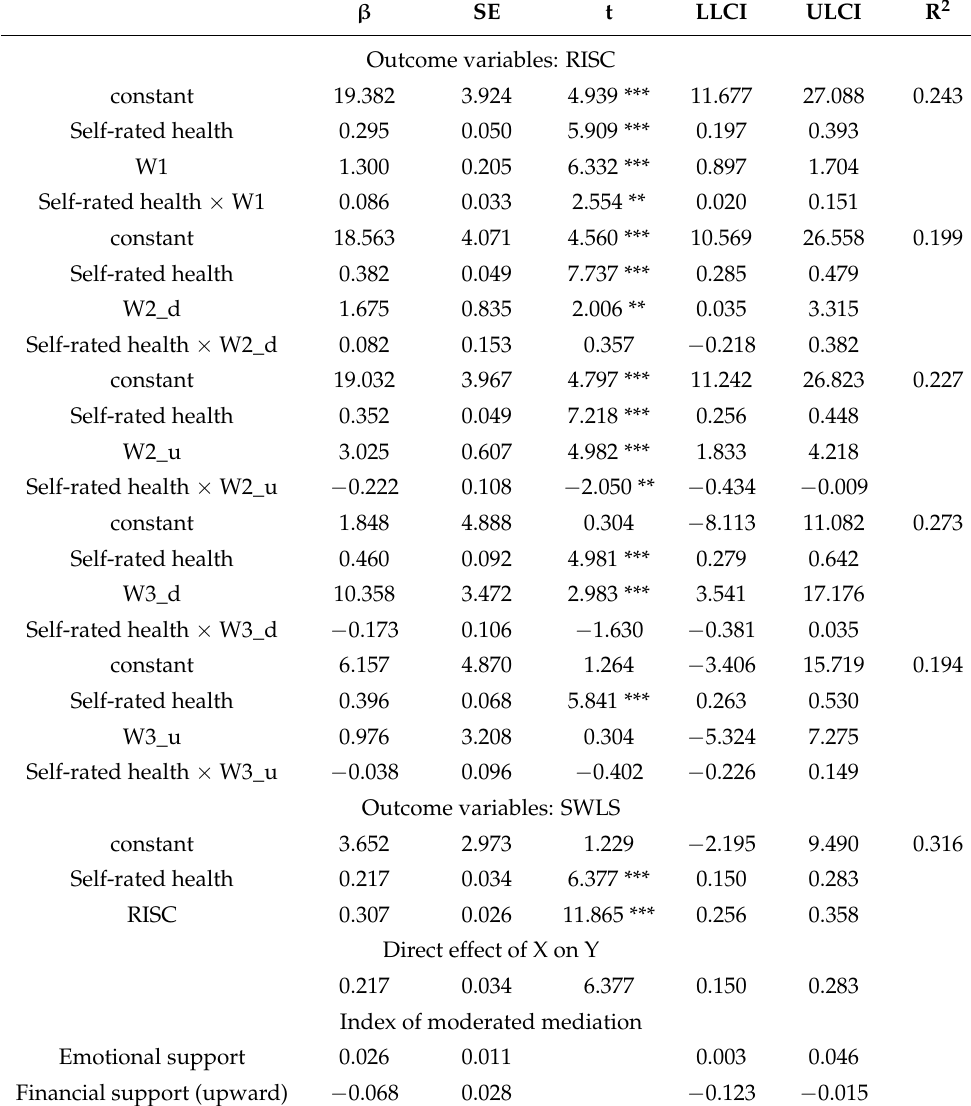
Table 4. Moderated mediation analysis results about the effect of self-rated health on life